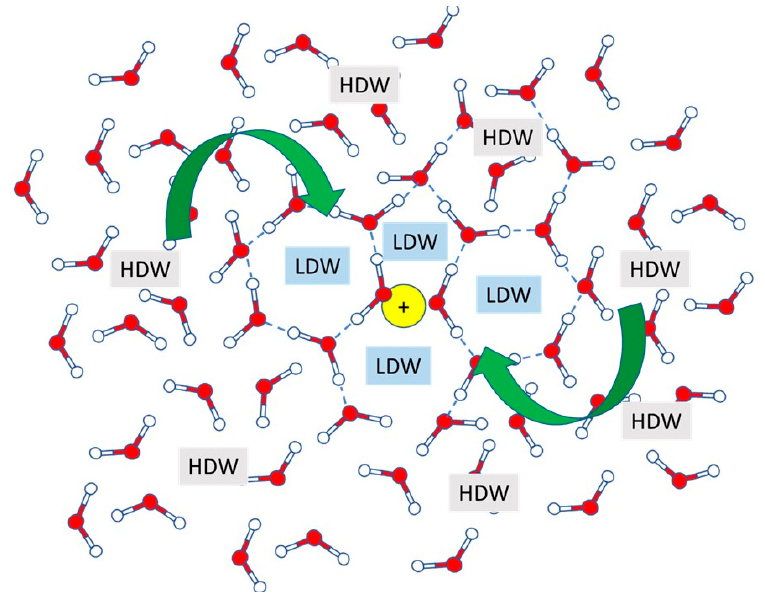
Figure 17. Kosmotropic ion dissolved in water. This is surrounded by a low-density water (LDW) microdomain which moves towards a high-density water (HDW) microdomain as the distance from the ion increases. The green arrows indicate the molecular exchanges between HDW and LDW domains.